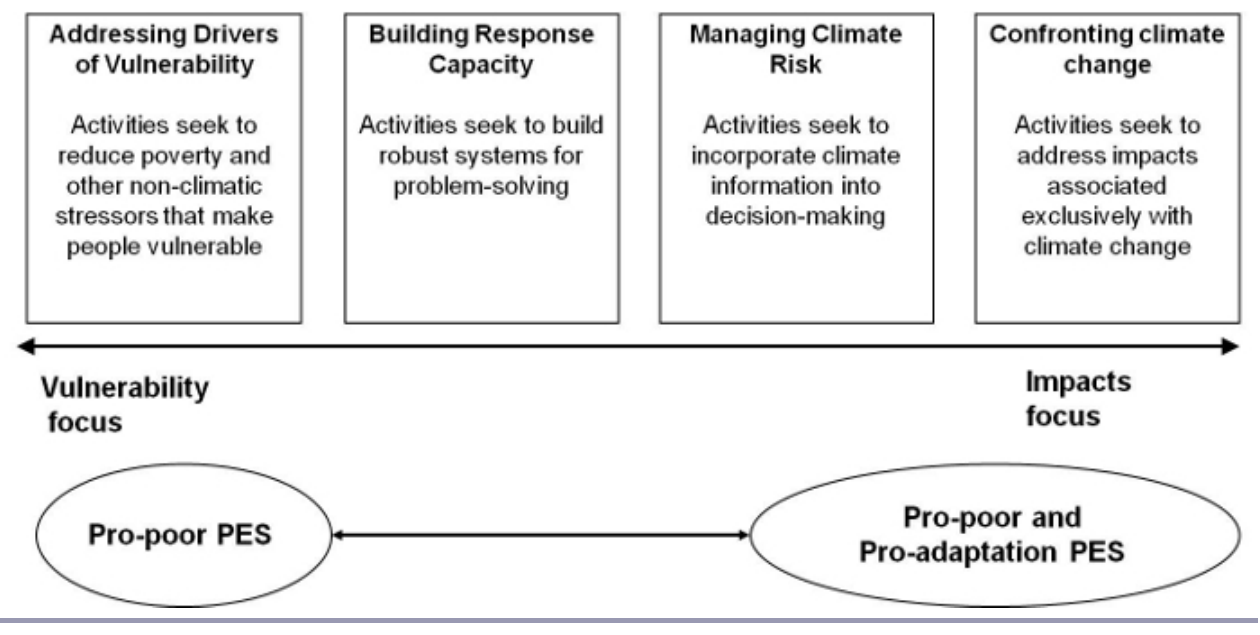
Fig. 2 . Adaptation as a continuum. Source: adapted from McGray et al. (2007) and Klein